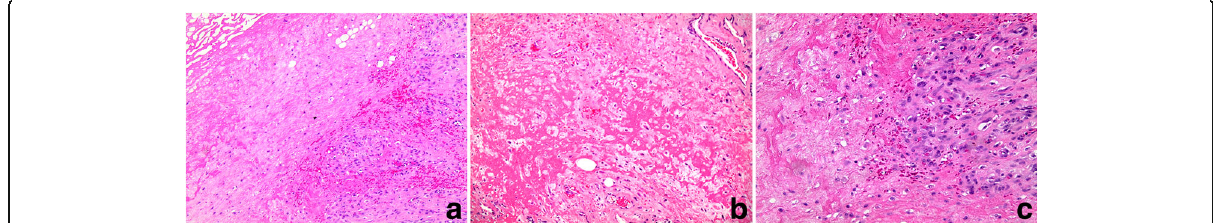
Fig. 2 a A low power image of Hematoxylin and Eosin (H&E) stained section is depicted here, demonstrating pattern of zonation with fibrinoid matrix deposition. Also, extravasation of red blood cells, proliferating atypical fibroblasts and so-called “ ghosted ” fat cells are seen. b A high power view of zonal fibrinoid matrix deposition with intervening proliferative fibroblasts is shown; a non-thrombosed vessel is present (top right). c A higher power view demonstrating plump and proliferative fibroblasts adjacent to focal fibrinoid